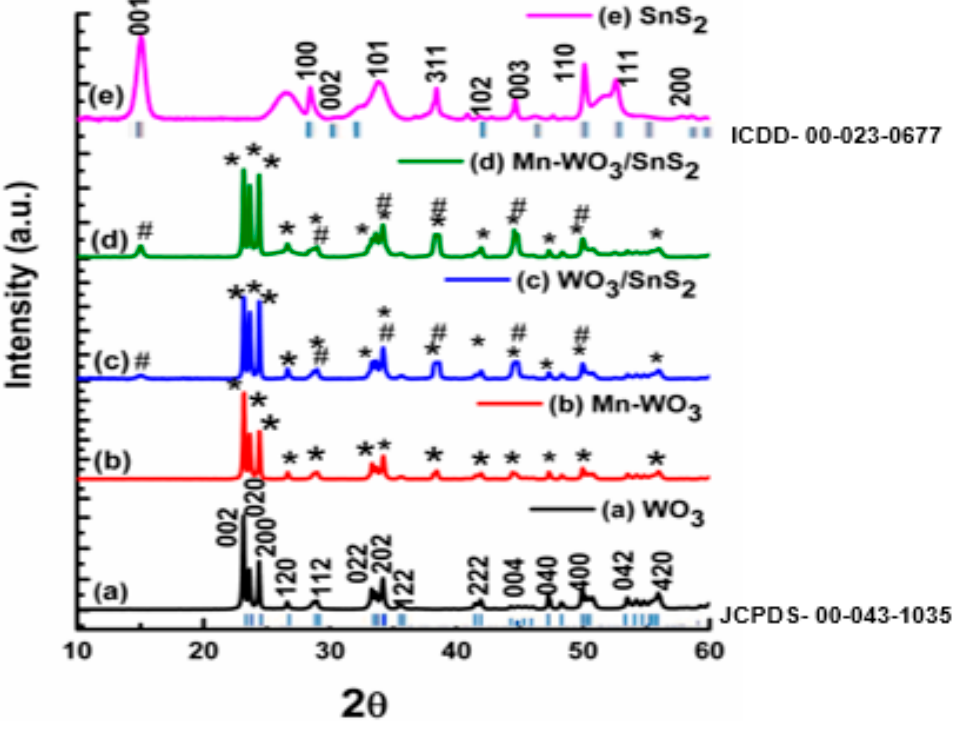
/ SnS / SnS 2 , ( d ) Mn-WO 3 2 and ( e ) SnS 2.